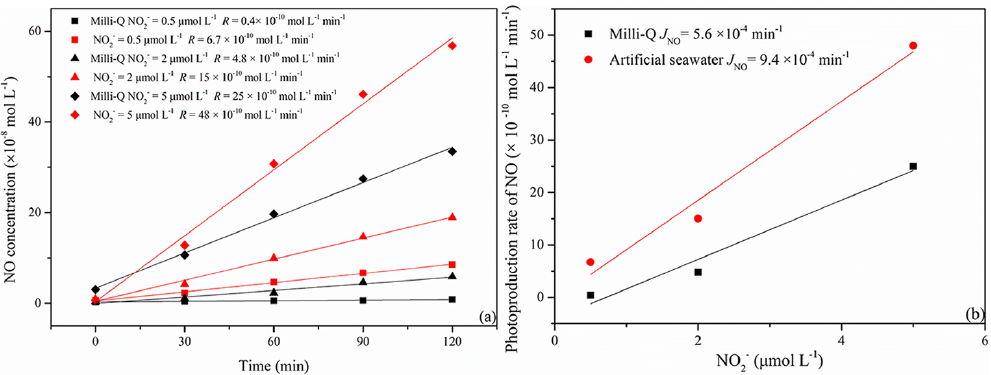
(a) and the calculated J NO values in Milli-Q water and artificial 2